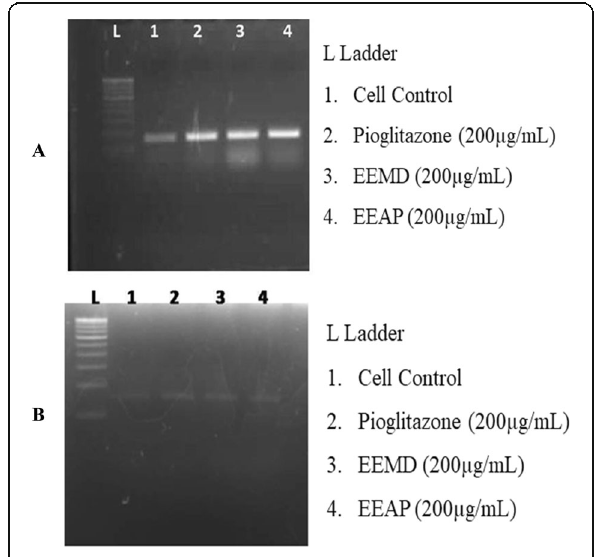
Fig. 5 Gene expression study : a Effect of extracts on GLUT-4 and b PPAR γ transcripts in L6 myotubes determined by RT-PCR